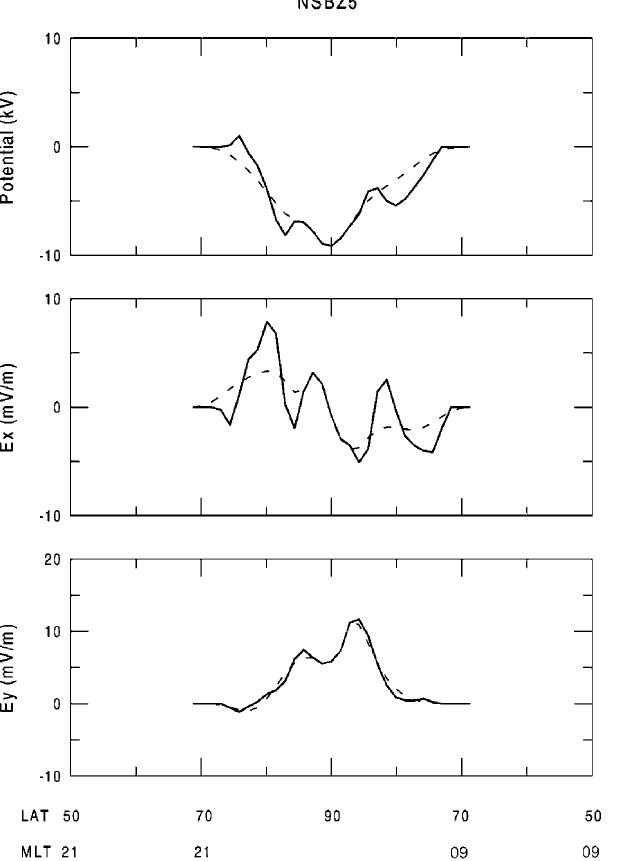
Fig. 6. Profiles of the electric potentials and electric field components ( E x and E y ) in the northern summer polar cap for IMF B x (cid:136) 0, B y (cid:136) 0, B z (cid:136) 5 nT along the MLT meridian 21-09. Solid lines are for the data from the IZMEM/DMSP model, dashed lines represent reconstructed values